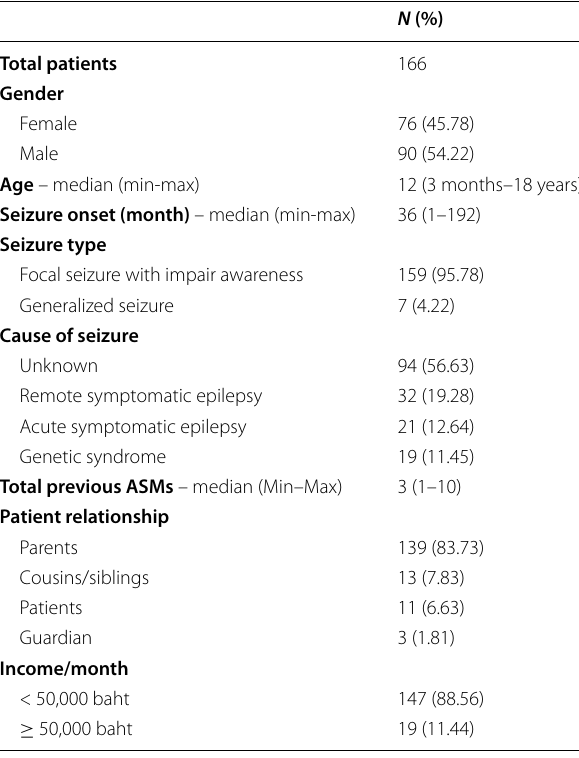
Table 1 Demographic and clinical characteristics of 166 pediatric epilepsy patients in